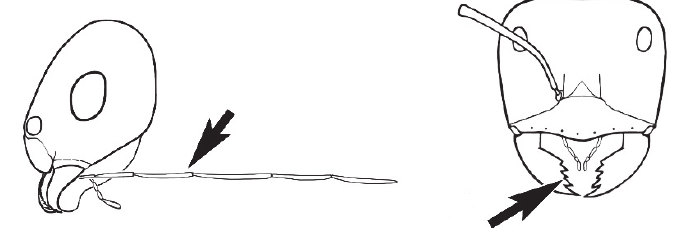
– Maxillary palp of variable length, but often extending beyond neck sclerite and always with lobiform terminal segment; PF < 6,4 where palp segments extremely reduced and difficult to see; metatibial apical spur nearly always present and elongate; in full-face view, masticatory margin of mandible in major worker usually not strongly oblique, but if so, then almost always with at least five teeth; minor workers with ≥ five teeth ..................................... 12